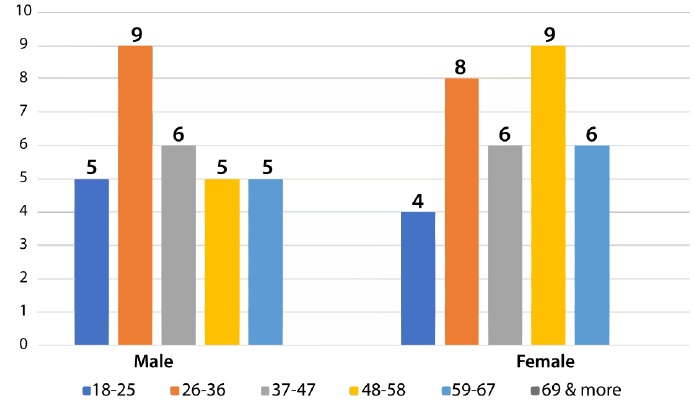
Figure 17. Classification of user by age.